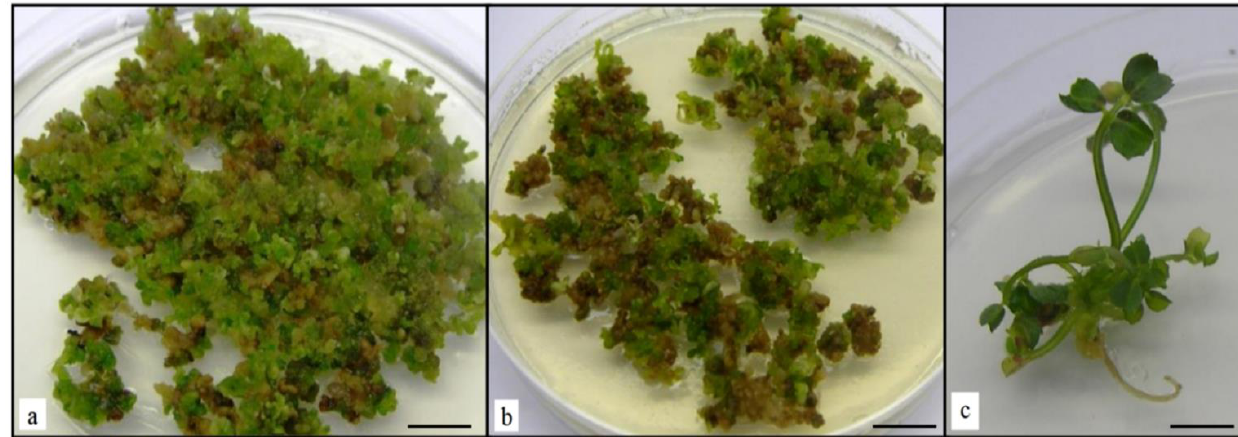
Figure 3. Embryo production from Medicago truncatula leaf explants. Embryos production on embryogenic calli formed from Medicago truncatula leaf explants transformed with pCambia1301- WUS-BAR ( a ) and from leaf explants transformed with pCambia- BAR (control) ( b ) after four weeks of culture on SH2 medium (without plant growth regulators). Plantlet developed from a WUS embryo of Medicago on SH2 medium ( c ). Bar 1.0 cm.